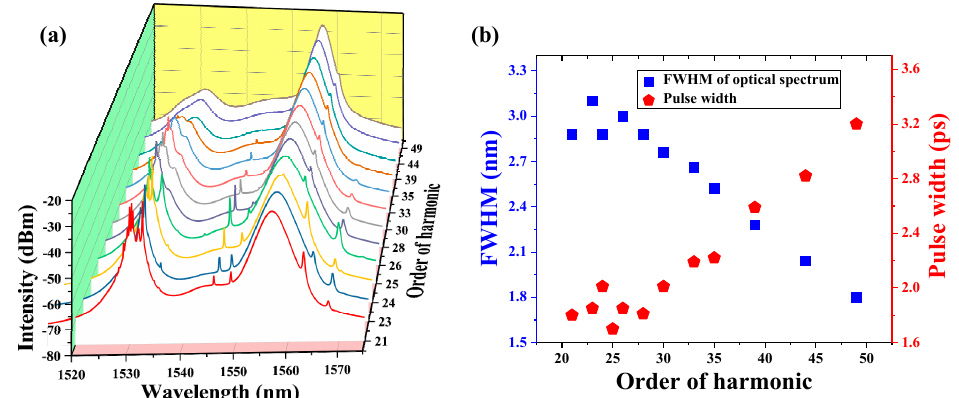
Figure 8. ( a ) Pulse trains from 21st – 49th, ( b ) corresponding RF spectra.